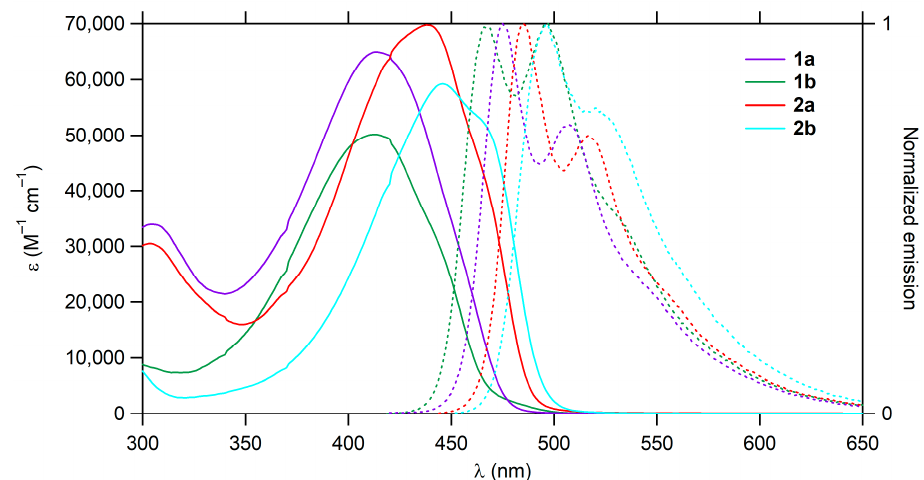
Figure 1. Absorption (solid lines) and emission (dashed lines) spectra of quadrupoles cores 1a , b and 2a , b in toluene. Table 3. CAM-B3LYP calculations for the four lowest-energy excitations of the most stable form ( a ) in toluene (PCM). E 0n is the transition energy (in eV), λ calc is the wavelength (in nm) and f 0n is the oscillator strength of the absorption transition.